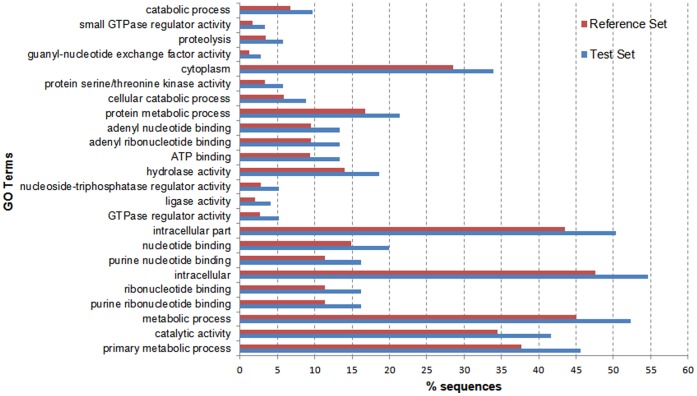
The enrichment analysis result for DTHPco.The percentages of sequences for test and reference set were shown in the bar chart in ascending order of significance level.